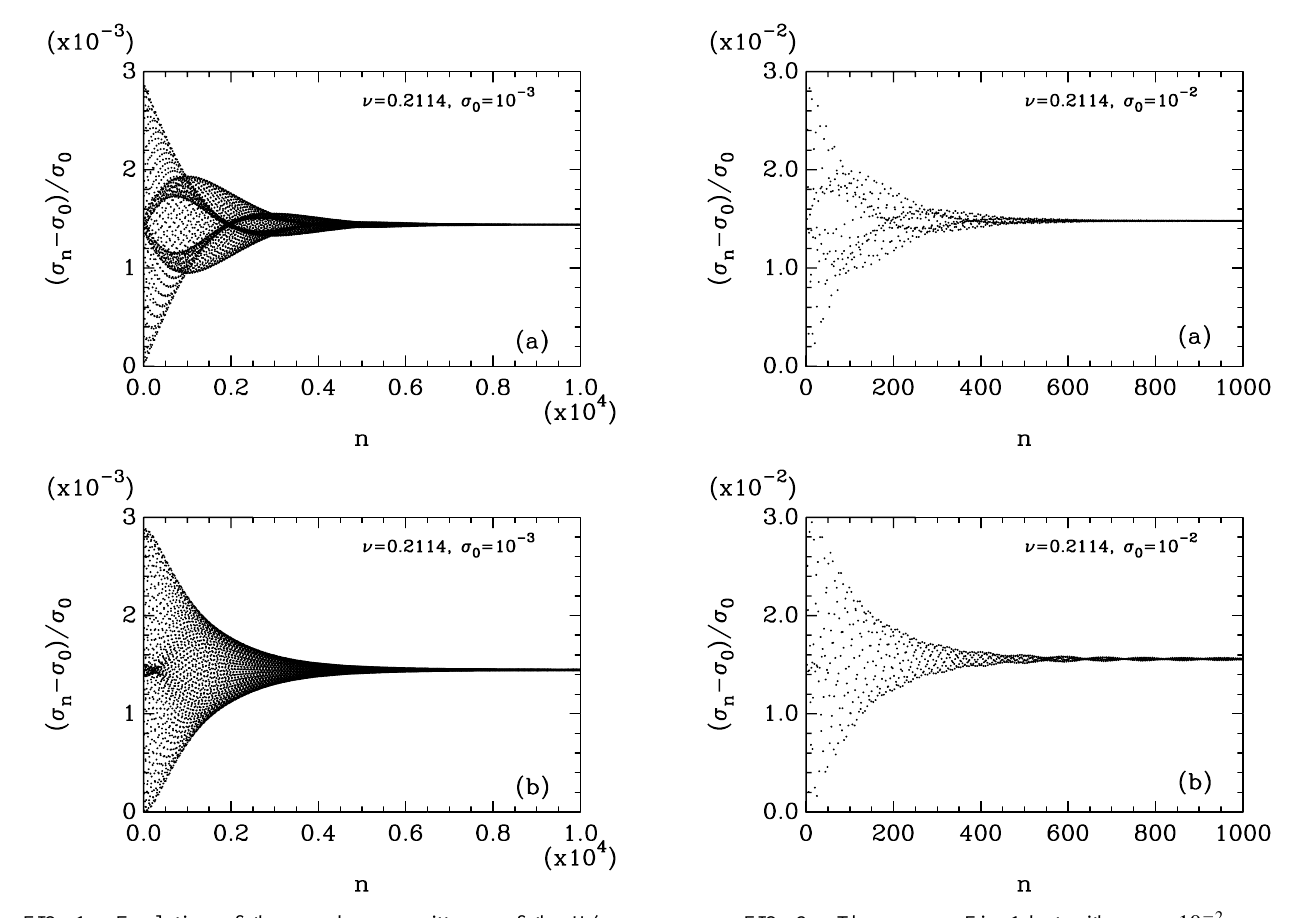
FIG. 2. The same as Fig. 1 but with s (cid:48) (cid:173) (cid:49)(cid:48) 2 (cid:50)